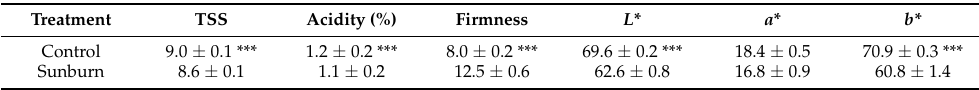
Table 2. Physicochemical analysis of sunburned and non-sunburned fruits of Citrus unshiu ‘Nichinan No. 1’.